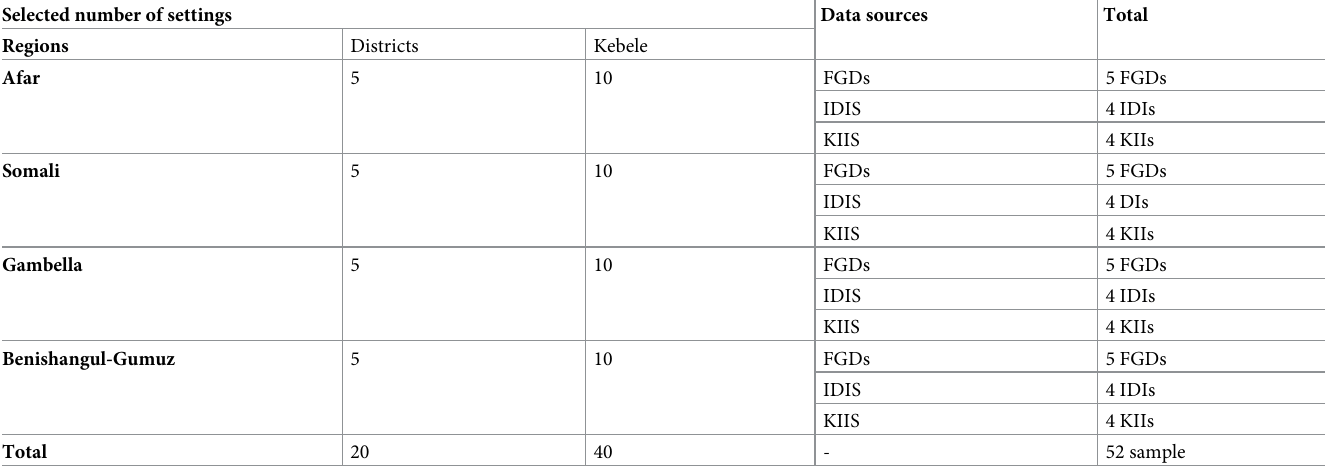
Table 1. Data sources by regions, gender intersectionality and MCH study, DRS of Ethiopia, 2019. Selected number of settings Data sources Total Regions